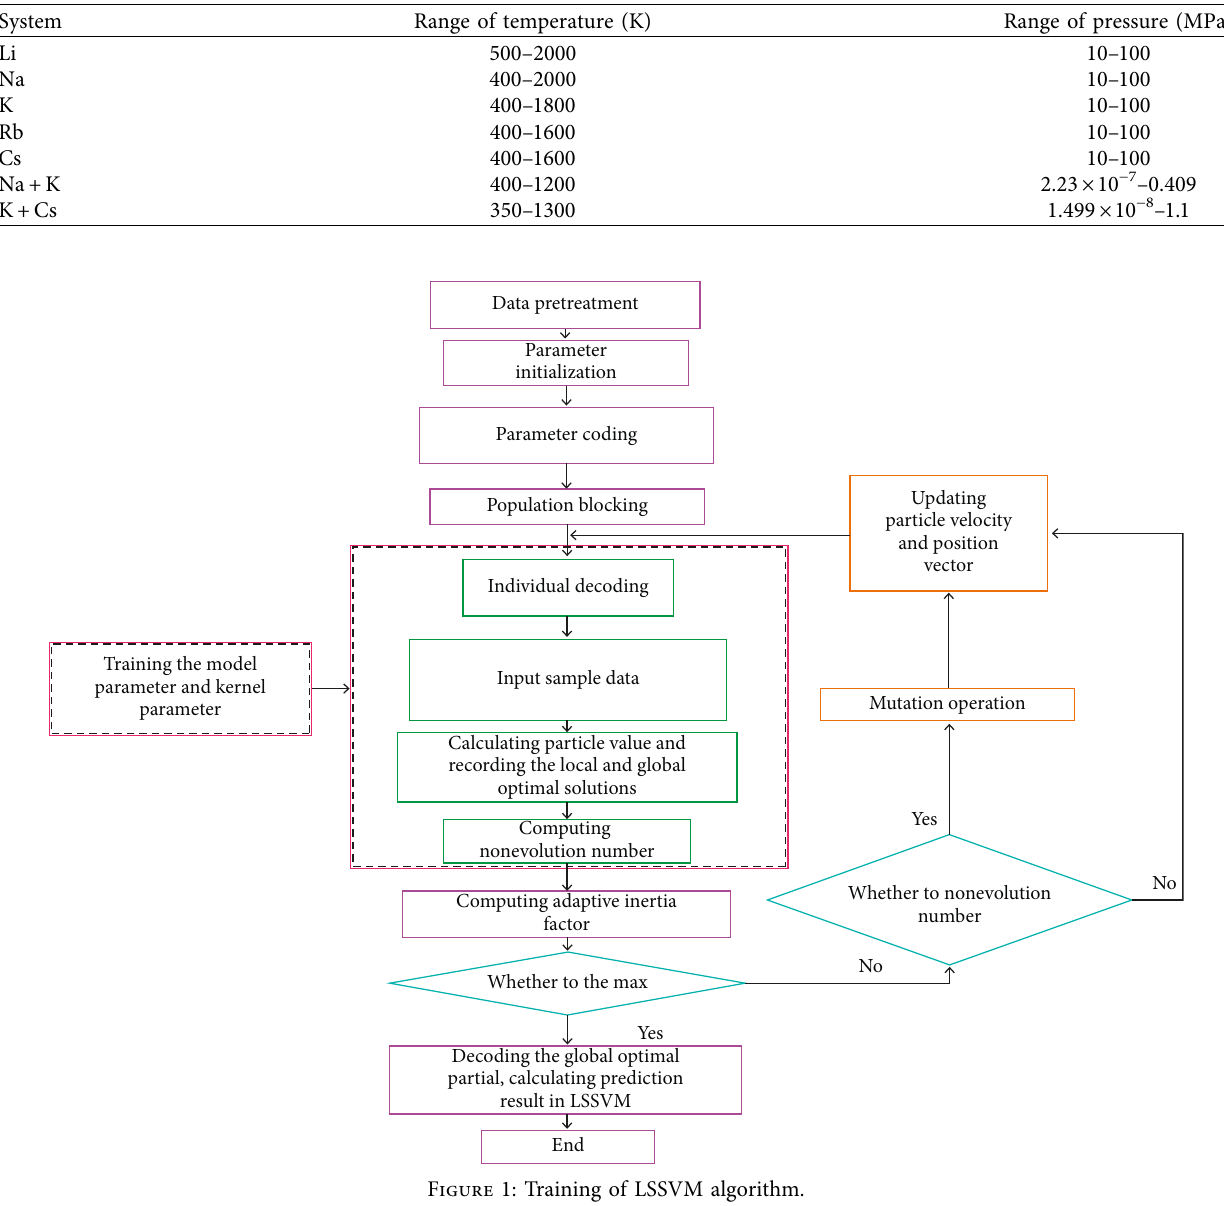
Table 1: Details of experimental data.